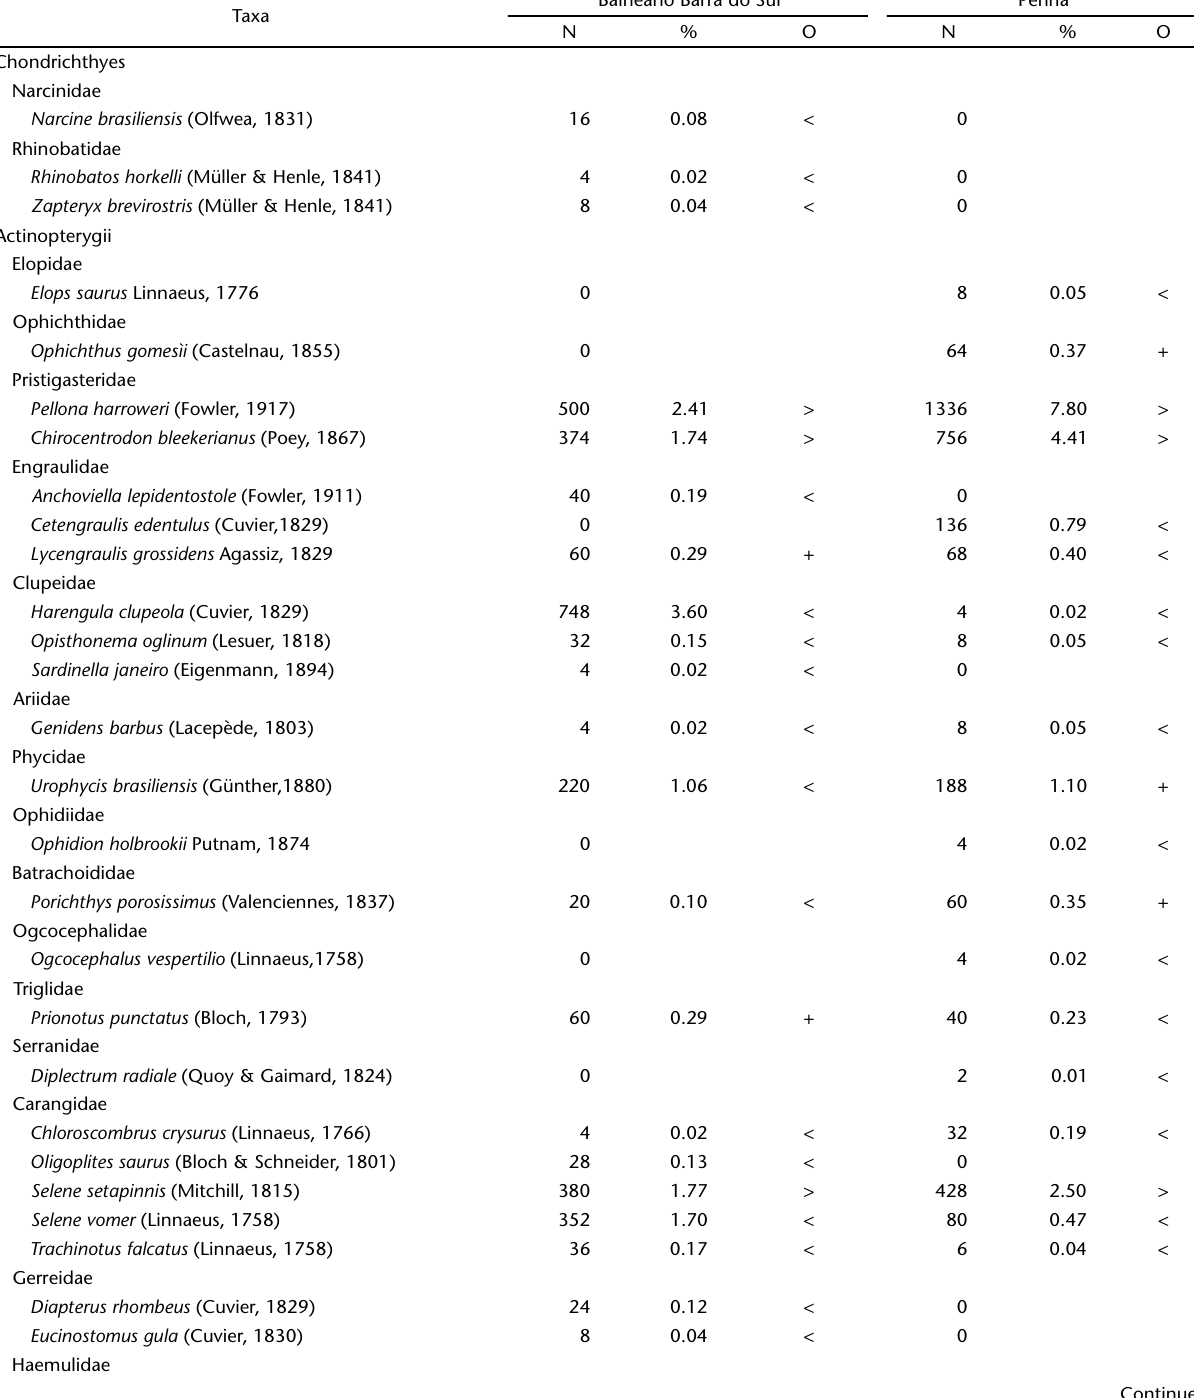
Table I. List of demersal fish species and their respective occurrence frequencies in Balneário Barra do Sul and Penha from March 2007 to February 2008. The occurrence (O) is represented as: (>) constant, (+) accessory, (<) incidental. N: abundance,%: relative percentage contribution. The families were distributed according to N ELSON (2006), and the species were listed in alphabetical